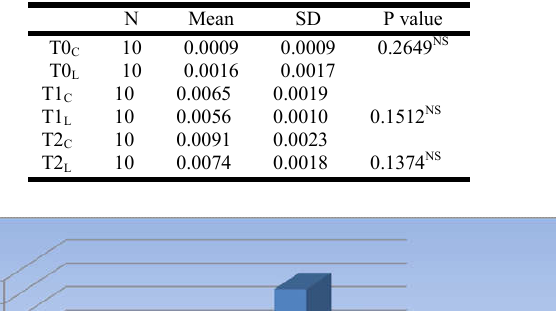
Table 2. Comparision of DSPP values (ngL -1 ) in GCF between central (T0 C ) and lateral incisors (T0 L ) withincontrol group, experimental group before intrusion (T1 C & T1 L ) and after intrusion (T2 C & T2 L ) N